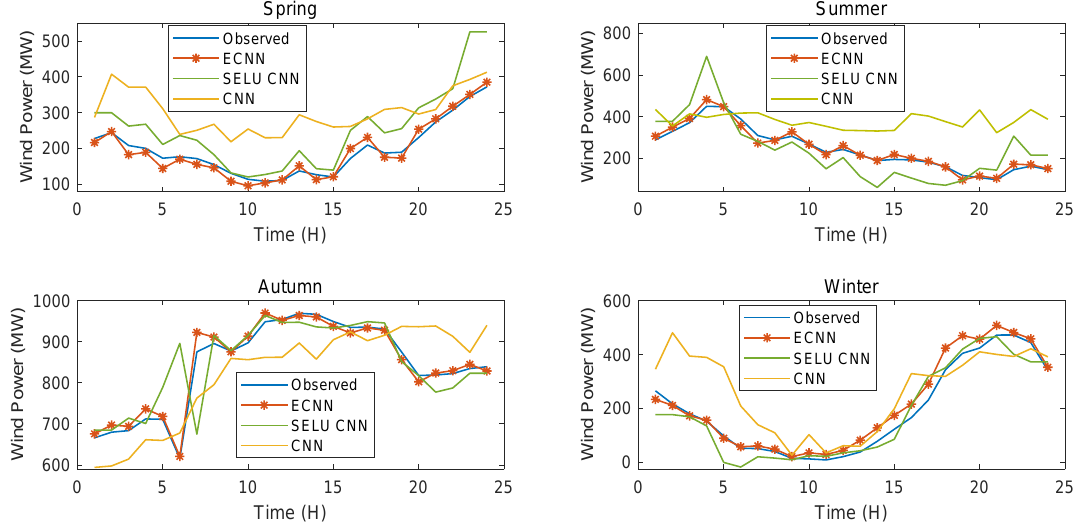
Figure 4. All season predictions of wind